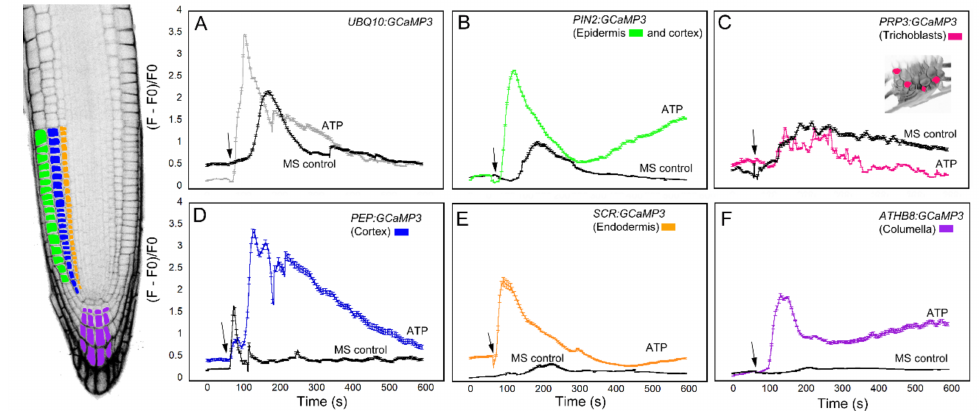
Figure 3. Time course of [Ca 2 + ] cyt changes in A. thaliana roots after 1 mM ATP application. The leftmost panel shows an inverted fluorescence image of the terminal 300 µ m of an A. thaliana primary root to illustrate di ff erent cells in which GCaMP3 was expressed. Cell types are color coded with green = epidermis; blue = cortex; orange = endodermis; purple = columella; and the pink cells in the inset in panel C = trichoblast. ( A – F ) Quantification of [Ca 2 + ] cyt -dependent fluorescence of various lines expressing GCaMP3 after ATP and solvent control (0.5 × MS) application. Black arrows indicate the time of treatment. Plotted values represent the average normalized fluorescence intensity from 3–6 regions of interest (ROI) per line with standard error bars every fifth time point. Fluorescence values were normalized to the lowest fluorescence